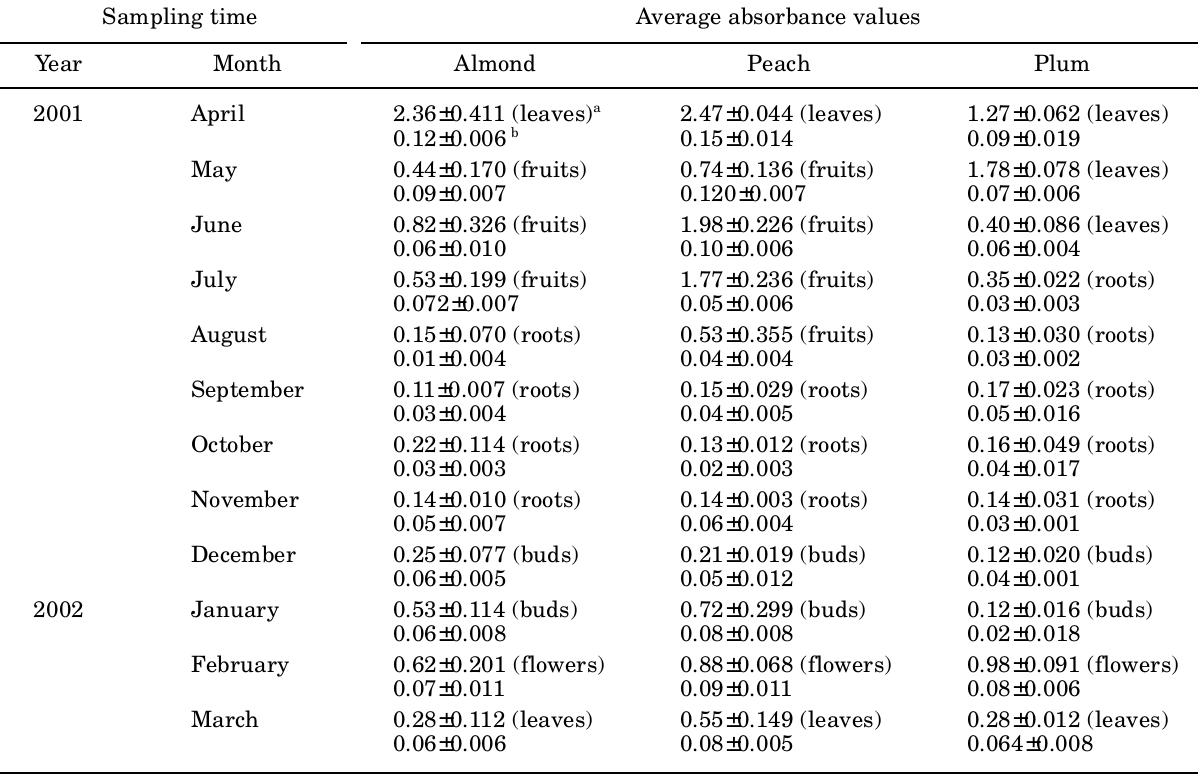
Table 1. Average absorbance values (A ) of plant tissues (leaves, fruits, roots, buds or flowers) from PNRSV- 405nm infected almond, peach, and plum trees tested in Tafila (Jordan) during 2001–2002.